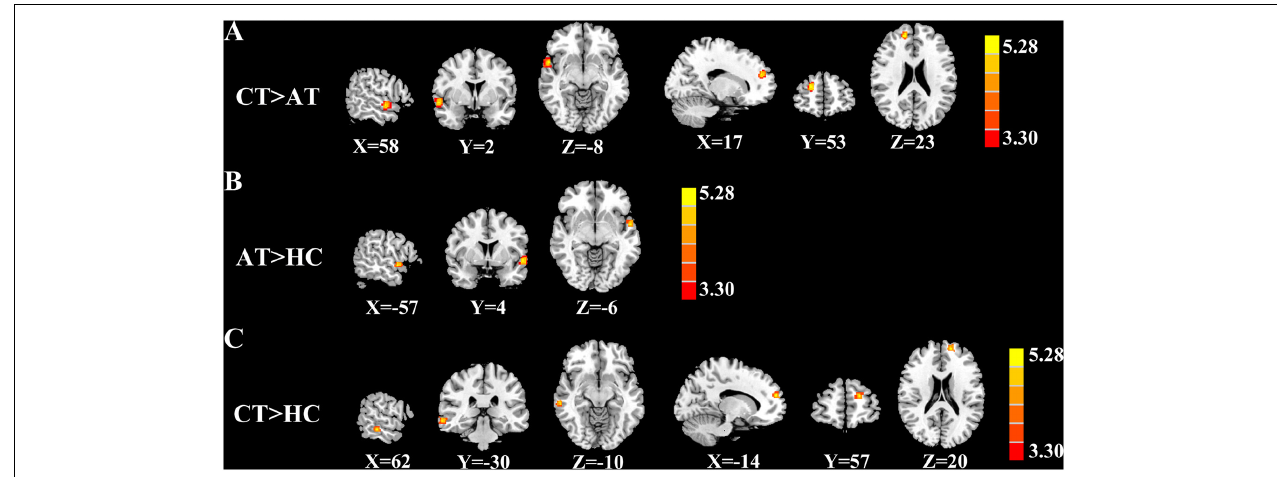
FIGURE 2 | Significant CBF differences among the chronic tinnitus (CT), acute tinnitus (AT), and healthy controls (HC). (A) Compared to AT, CT showed increased z-CBF in the right superior temporal gyrus (STG), and right superior frontal gyrus (SFG). (B) Compared to HC, AT showed higher z-CBF in the left STG. (C) Compared to HC, CT showed increased z-CBF in right middle temporal gyrus (MTG) and left SFG. Significant thresholds were corrected using FDR criterion and set at p < 0.01.